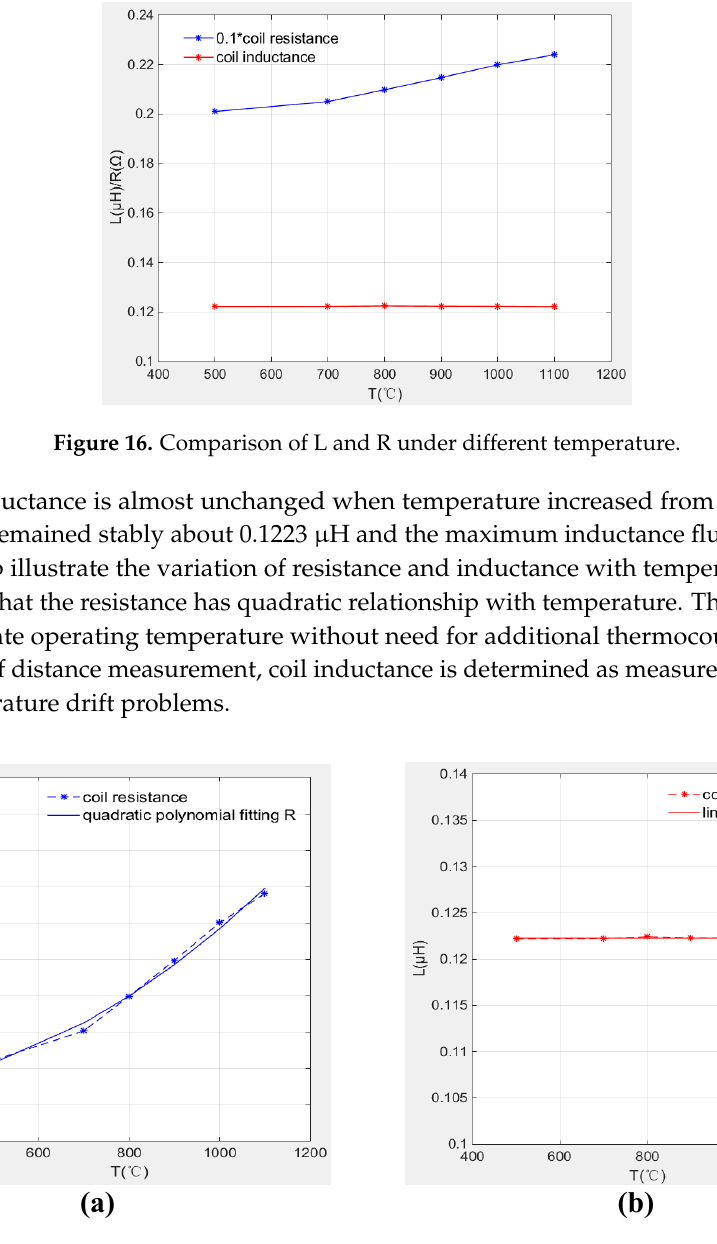
Table 3. Polynomial coefficient of R and L.